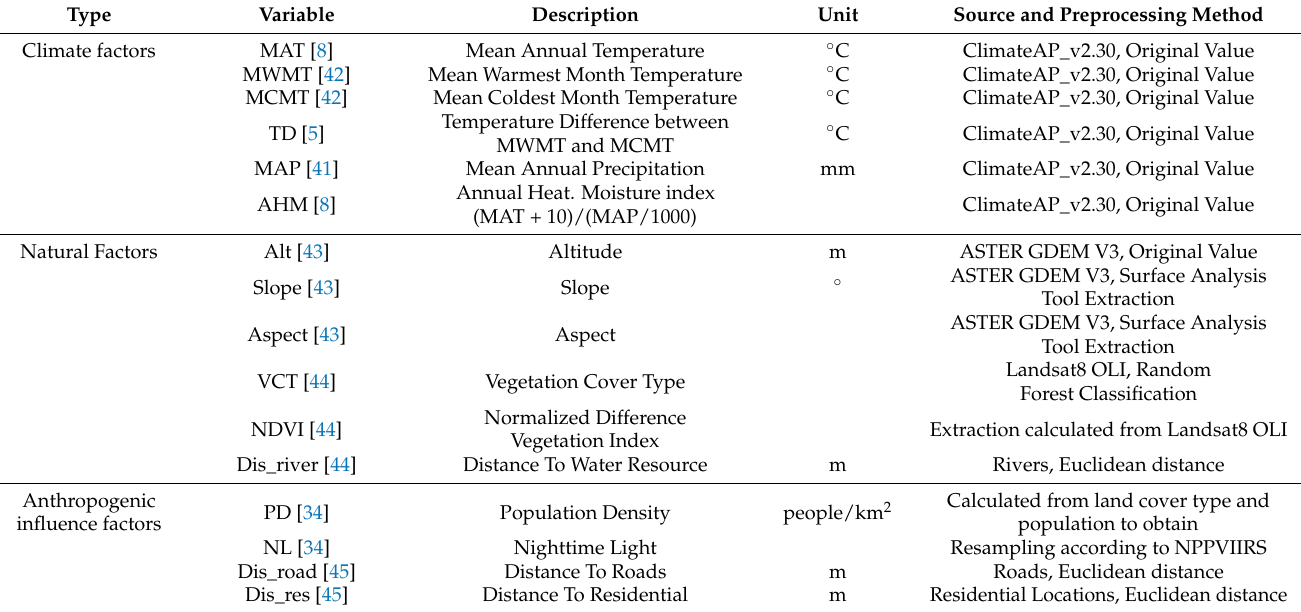
Table 1. Environmental variables used in predicting the distribution of Asian elephants in